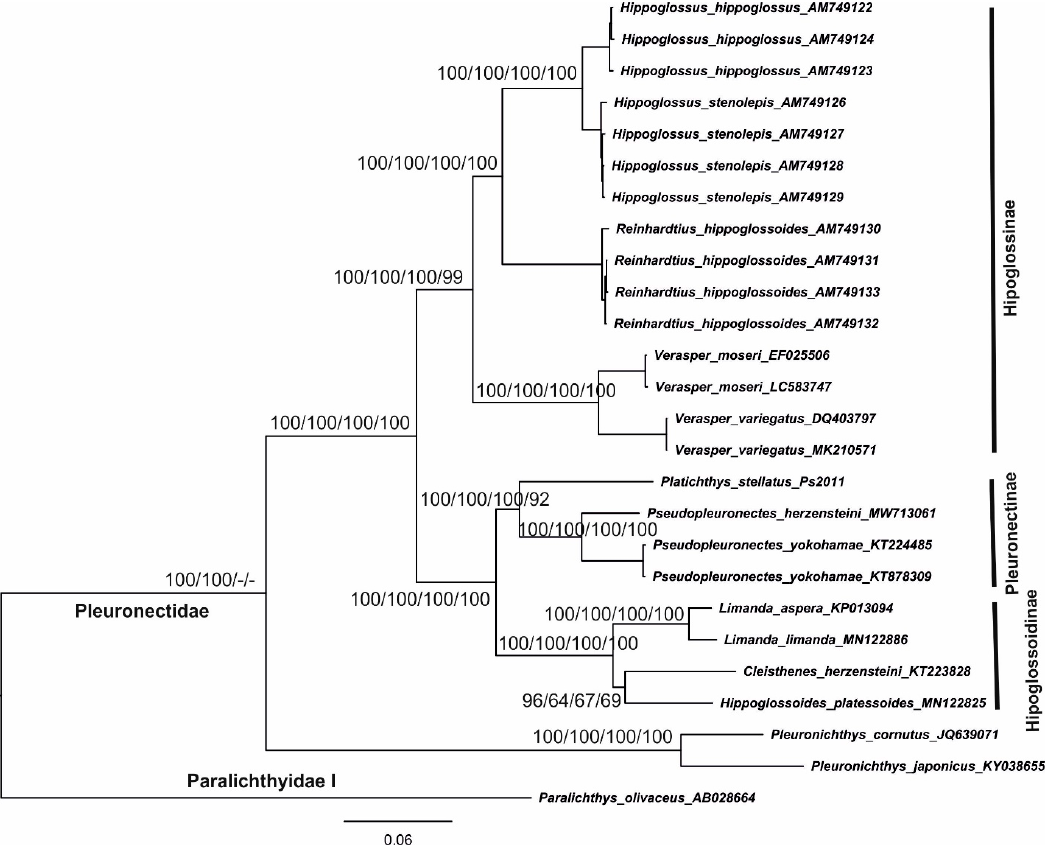
Figure 3. Molecular phylogenetic relationships of flounders of the family Pleuronectidae recon- structed using four approaches: BA, ML, NJ, and MP. Support values (%) at the tree nodes are shown in the direction: BA/ML/NJ/MP. For BA reconstructions, posterior probabilities for model genera- tions, n = 10 6 as well as for the other three techniques, bootstrap replicas, k = 1000 are given. Supports for intraspecific nodes are omitted. The tree is rooted in the outgroup Paralichthys olivaceus .